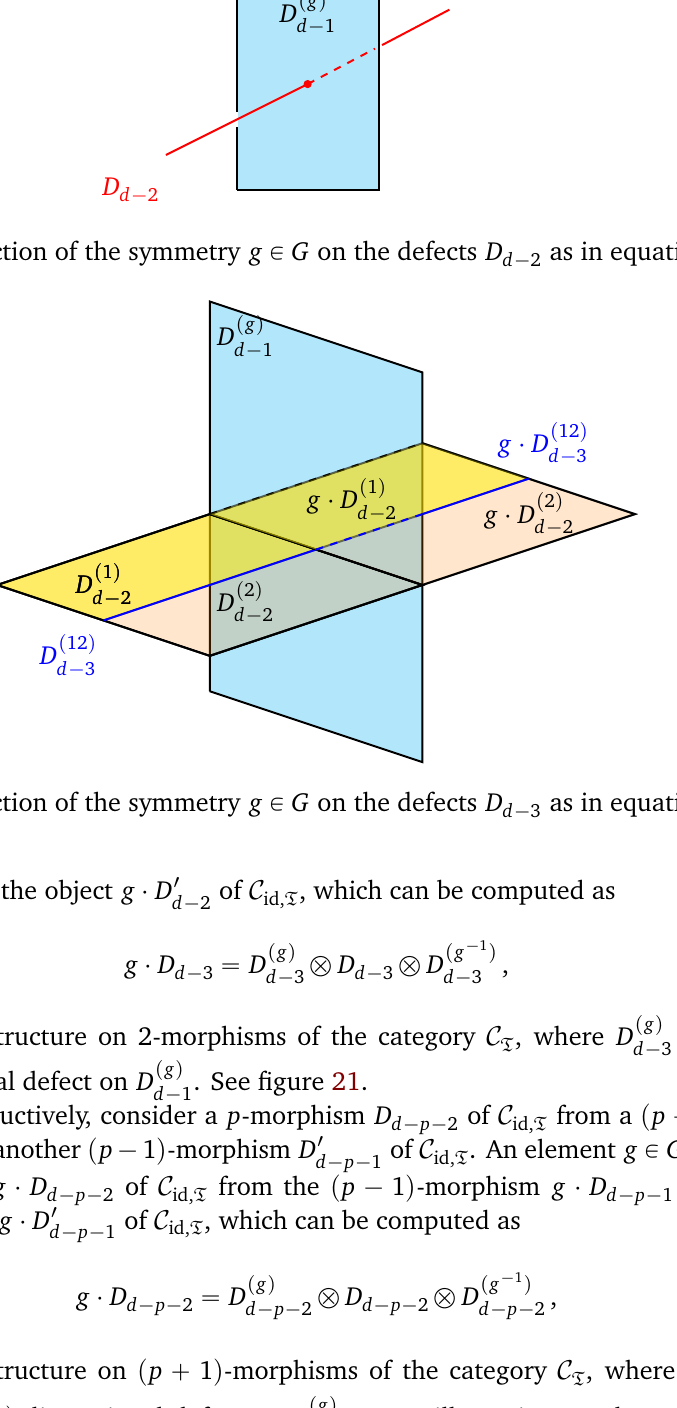
Figure 20: Action of the symmetry g P G on the defects D